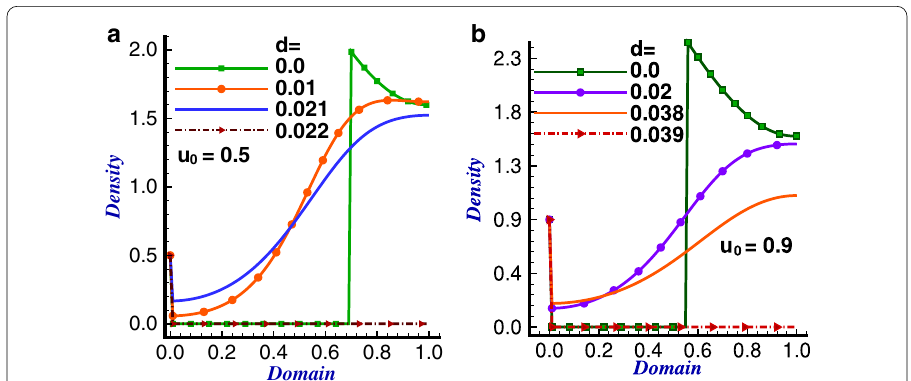
200 in ( a ) solutions = 1.2 cos (π x ) and = +